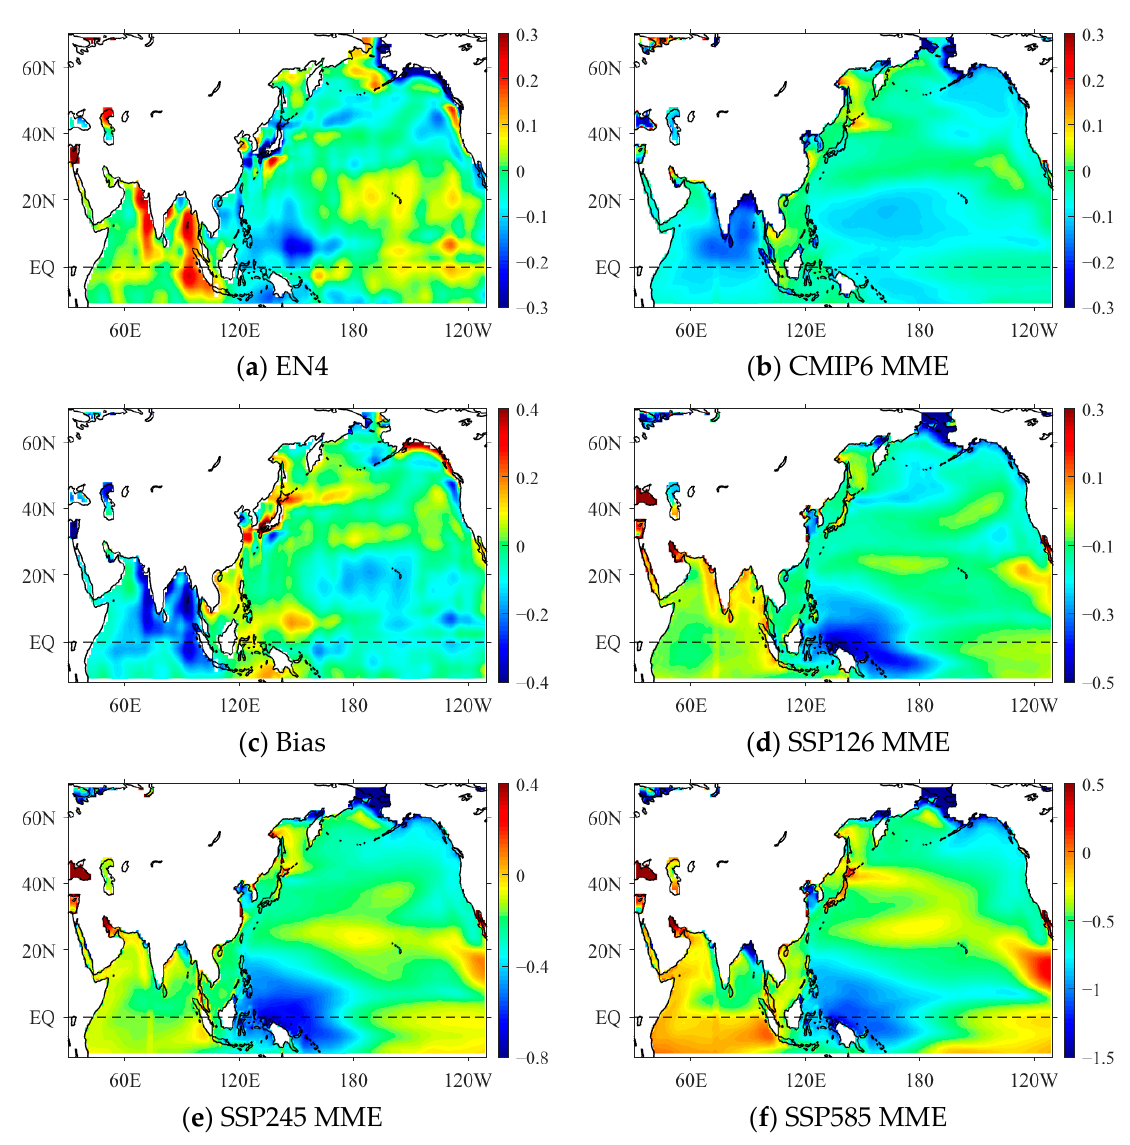
Figure 7. Linear trends of the sea surface salinity (SSS) for the historical period (1900–2014) and the future period (2015–2100). ( a ) EN4; ( b ) multi-model ensemble mean (MME) of the CMIP6 historical simulation; ( c ) biases between the CMIP6 MME and EN4; ( d ) SSP126, ( e ) SSP245, and ( f ) SSP585 are the multi-model ensemble means of the SSS trend for the future scenario simulations under the Shared Socio-Economic Pathway (SSP) in CMIP6 models (unit: